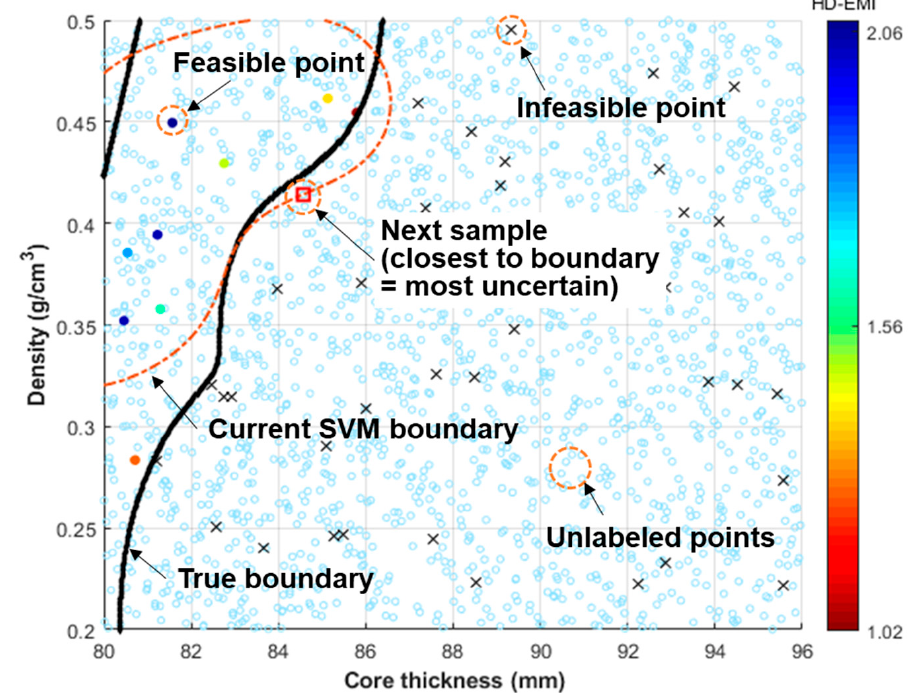
Figure 7. Active learning method for support vector machine(SVM).